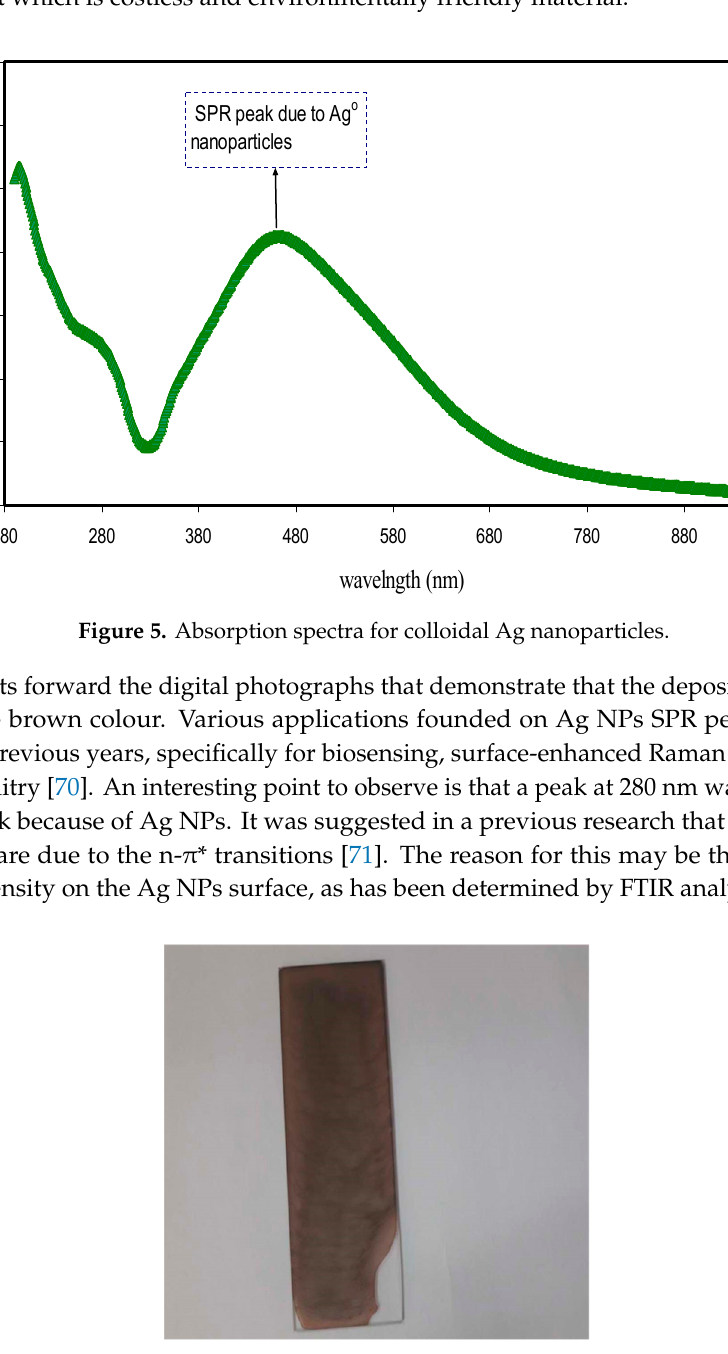
Figure 6. Photograph for deposited silver nanoparticles. The intense brown colour confirms the formation of Ag nanoparticles (NPs).